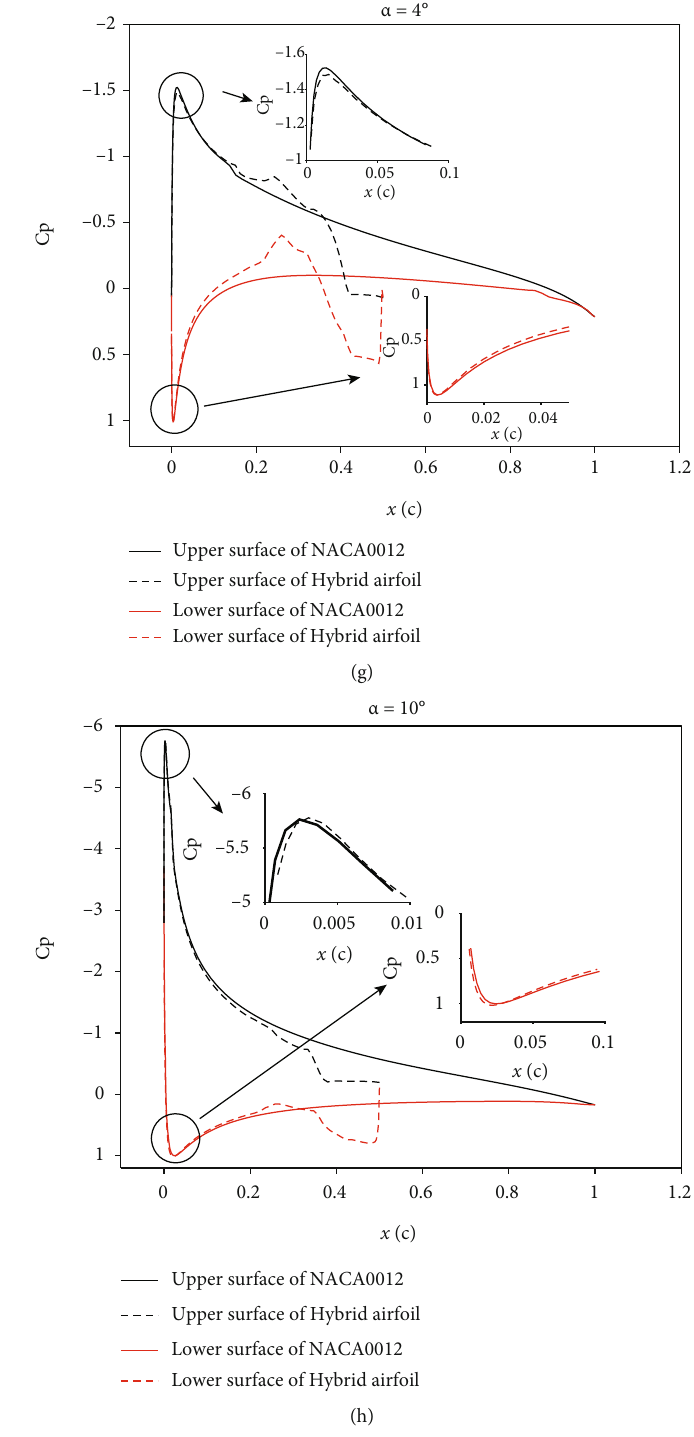
Figure 9: Pro fi le of hybrid airfoils and comparison of Cp: (a) pro fi le of hybrid airfoil under 0 degree, (b) pro fi le of hybrid airfoil under 2 degrees, (c) comparison of pressure coe ffi cient of hybrid airfoil Hy00 and full-scale airfoils, (d) comparison of pressure coe ffi cient of hybrid airfoil Hy02 and full-scale airfoils, (e) pro fi le of hybrid airfoil under 4 degrees, (f) pro fi le of hybrid airfoil under 10 degrees, (g) comparison of pressure coe ffi cient of hybrid airfoil Hy04 and full-scale airfoils, and (h) comparison of pressure coe ffi cient of hybrid airfoil Hy010 and full-scale